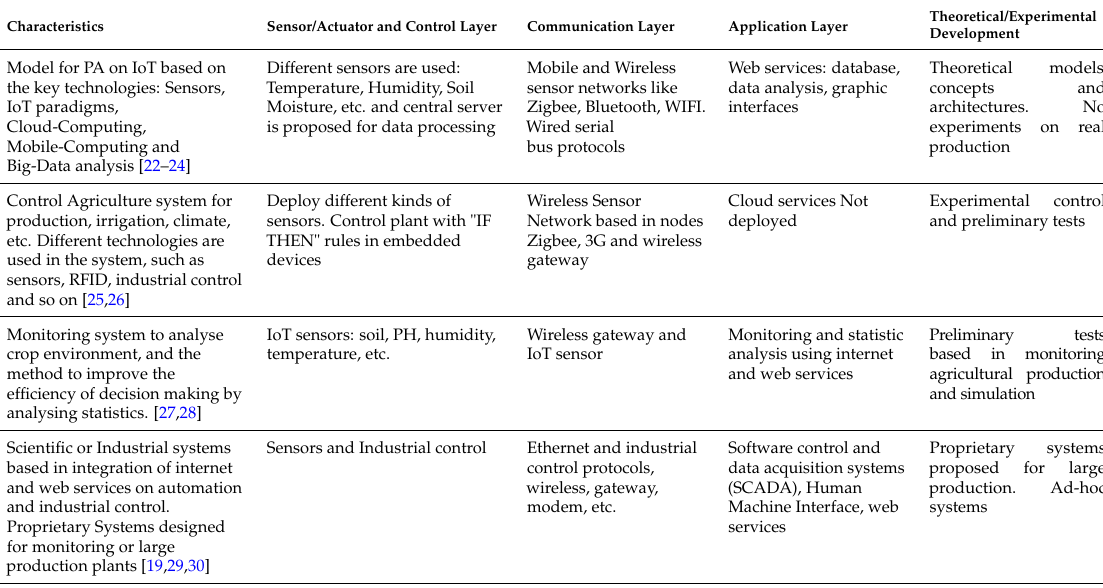
Table 1. Related IoT and USN PA works. Main